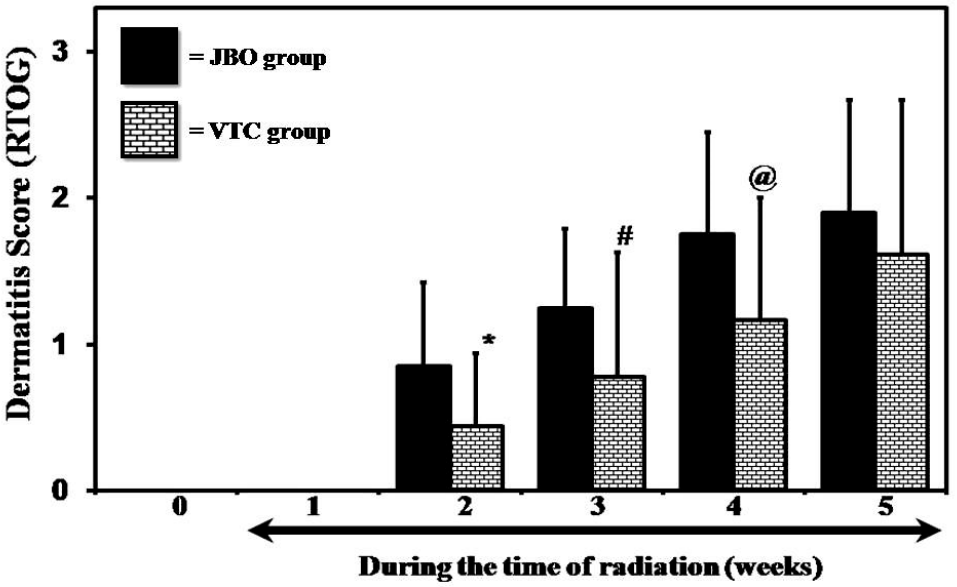
Figure 1. Different in the degree of radiation ‐ induced dermatitis (Student’s “ t ” test * is p < 0.02; # is p < 0.05 and @ is p < 0.03).